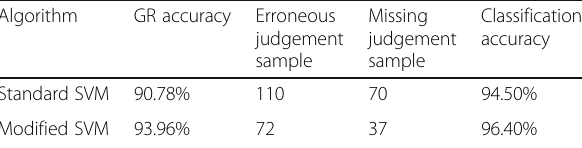
Table 2 Comparison of classification effect between original SVM and the proposed